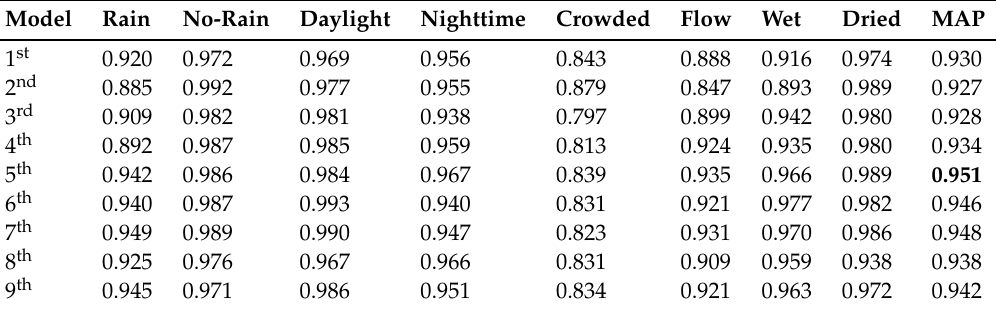
Table 4. Average precision of each class.